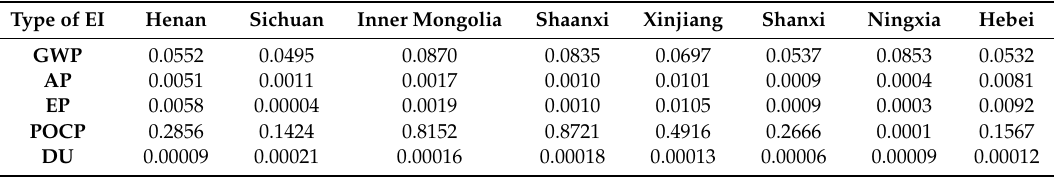
Table 7. Weightage value of the liquefied natural gas production in the eight provinces of China (per unit / kg).